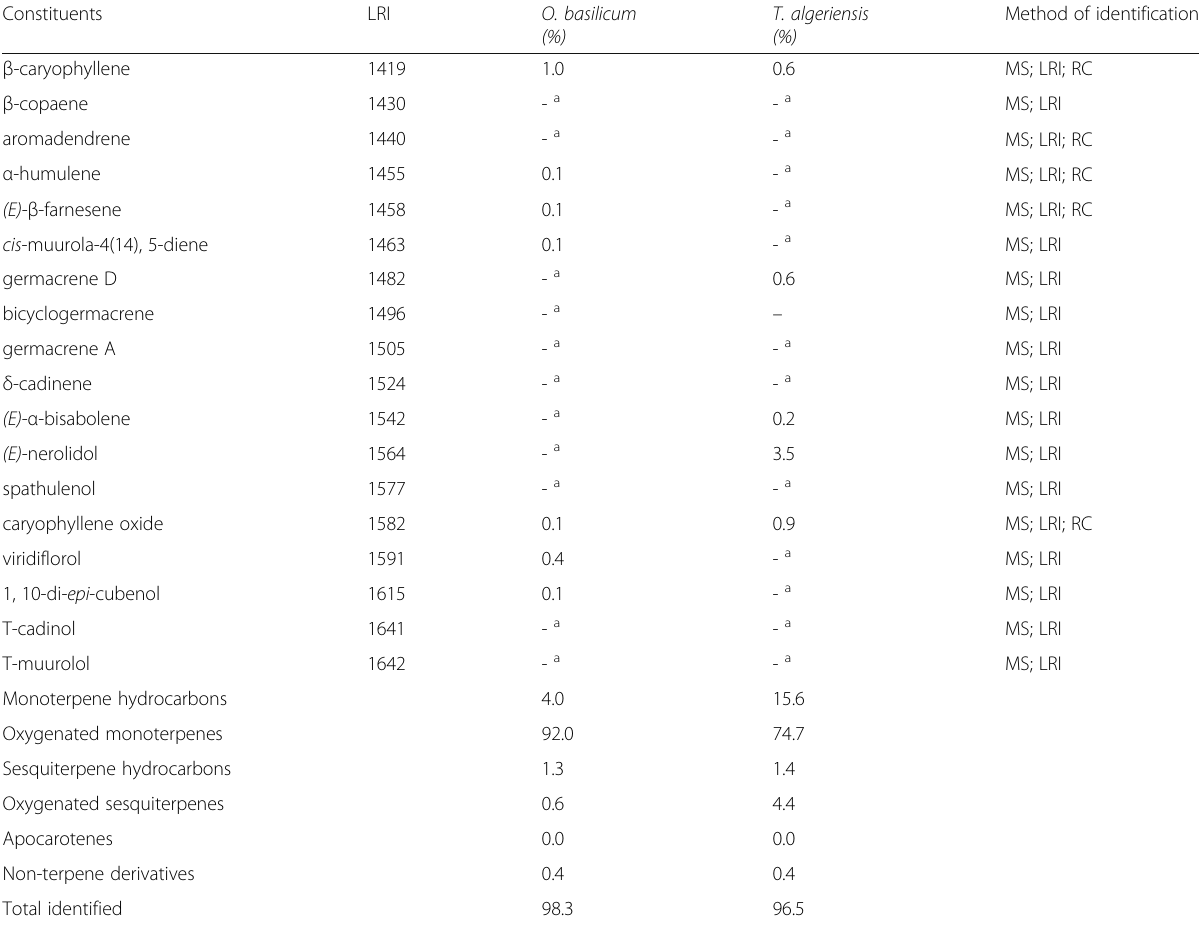
Table 3 Chemical composition of the essential oils extracted from the leaves of O. basilicum and T. algeriensis (Continued) Constituents LRI O. basilicum (%)